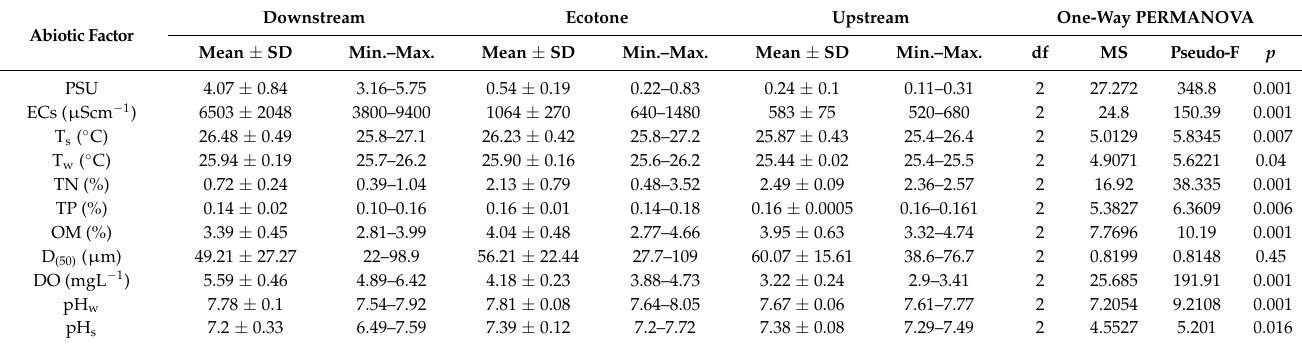
Table 2. Abiotic properties (mean ± SD, min.–max.) of sampling stations representing three habitats along the Van Uc River. T w — water temperature, T s — sediment temperature, DO — dissolved